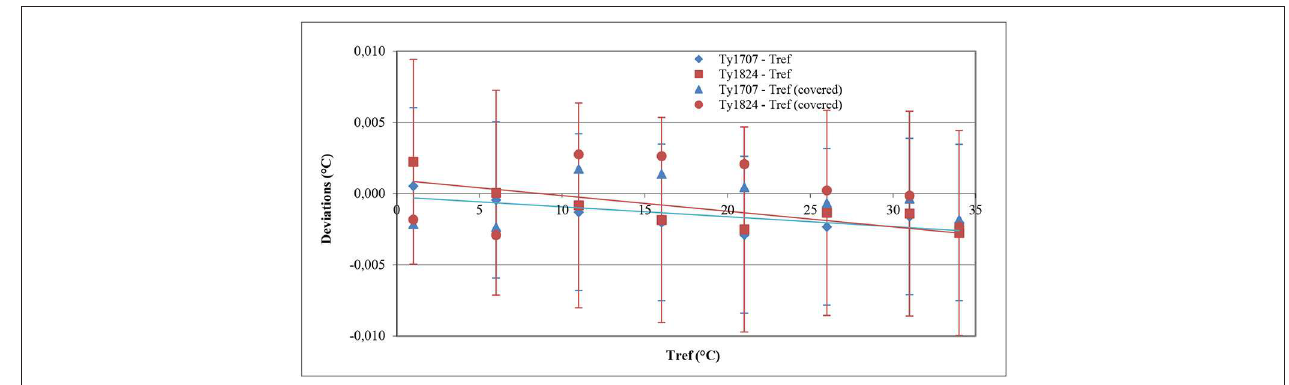
FIGURE 7 | Deviations obtained during the verification of HRSST sensors of two buoys during the two series, with the expanded uncertainty of the verification.